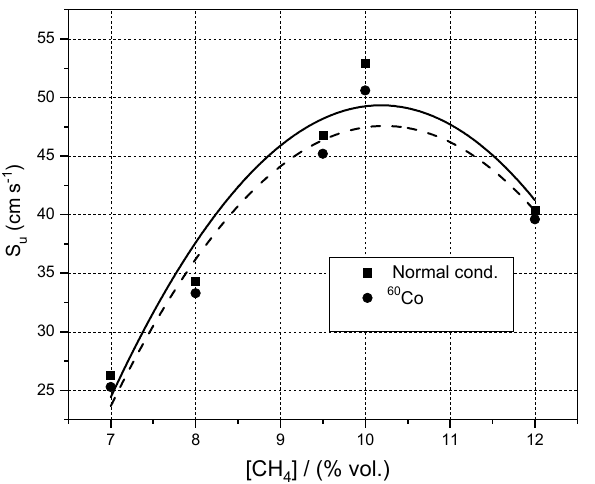
Figure 5. Normal burning velocities of CH 4 –air at various initial concentrations in the presence of radiation from 60 Co; experimental data.